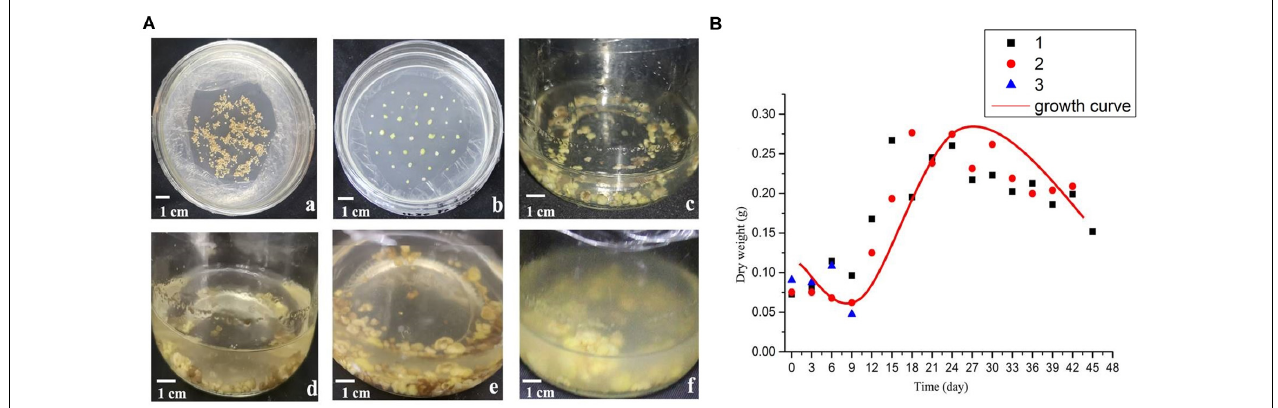
FIGURE 1 | Morphology and growth curve of B. striata suspended cellus. (A) The growth state of B. striata cells in suspension culture system at different stages. (a) Induction culture for 45 days. (b) Subculture for 30 days. (c) Suspension culture for 3 days; (d) Suspension culture for 9 days; (e) Suspension culture for 15 days; (f) Suspension culture for 27 days. (B) The cell growth curve in suspension